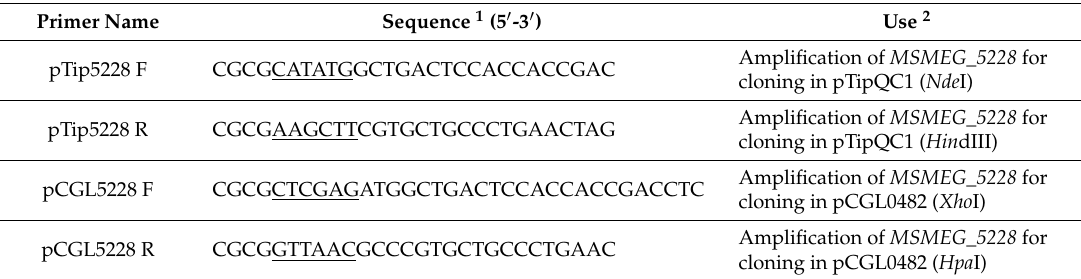
Table 2. Oligonucleotides used in this